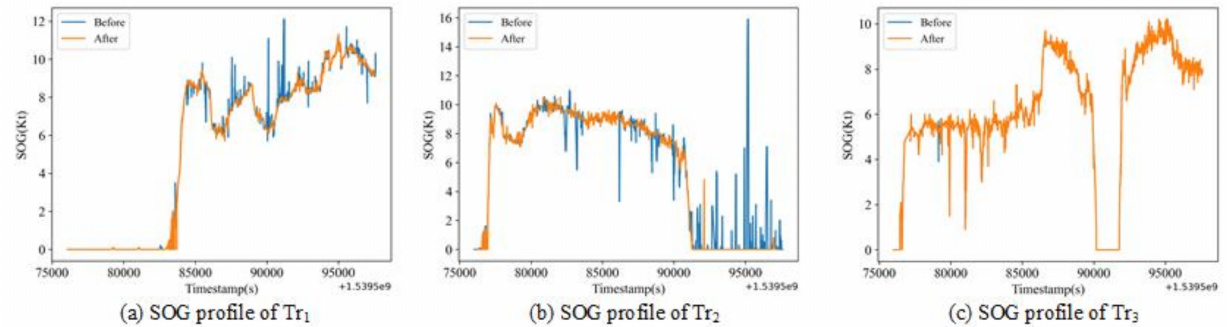
Figure 11. Comparison between the original trajectory and anomaly-removed trajectory from the speed perspective.